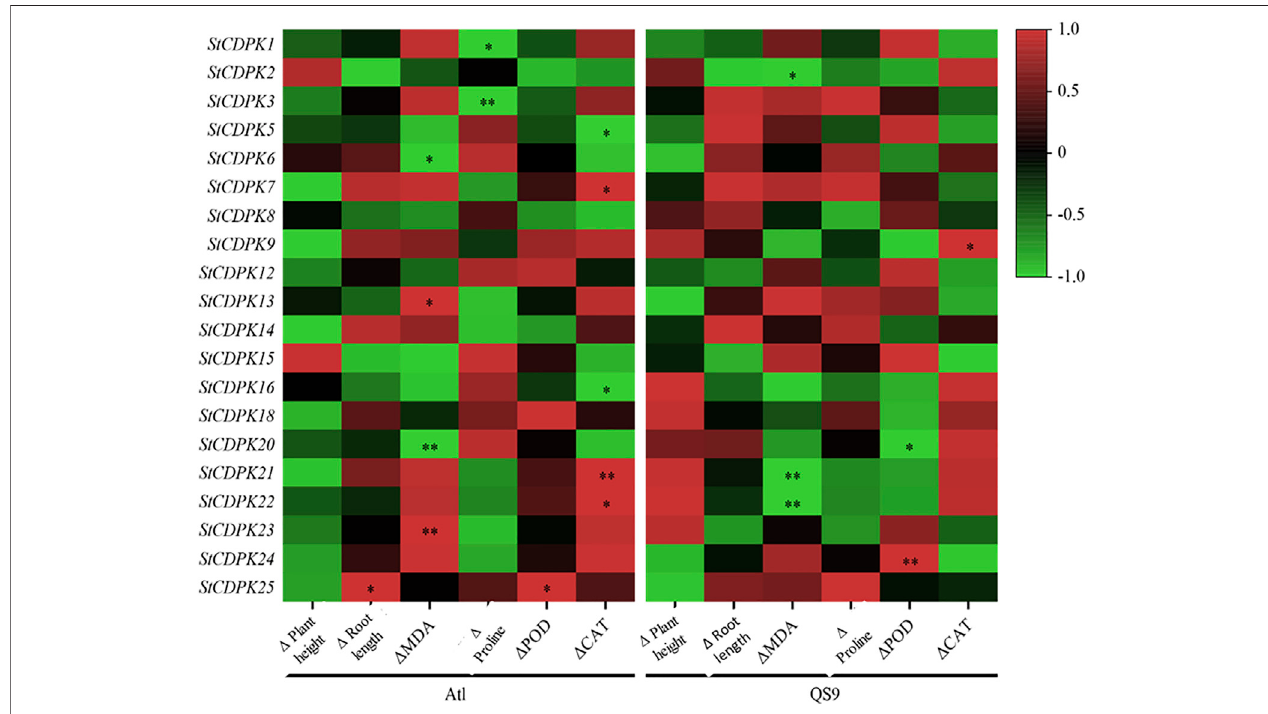
FIGURE 9 | tCorrelation analysis between StCDPKs gene expression and physiological and biochemical indexes of Atl and QS9 under drought treatment. Six phenotypicandphysiologicalparameterswereexaminedon15,20,and25 days,respectively.Redcolorindicatespositivecorrelation,blackcolorrepresentsnocorrelation, and green color shows a negative correlation. * indicates signi fi cant correlation at p < 0.05 level, while ** indicates a highly signi fi cant correlation at p < 0.01